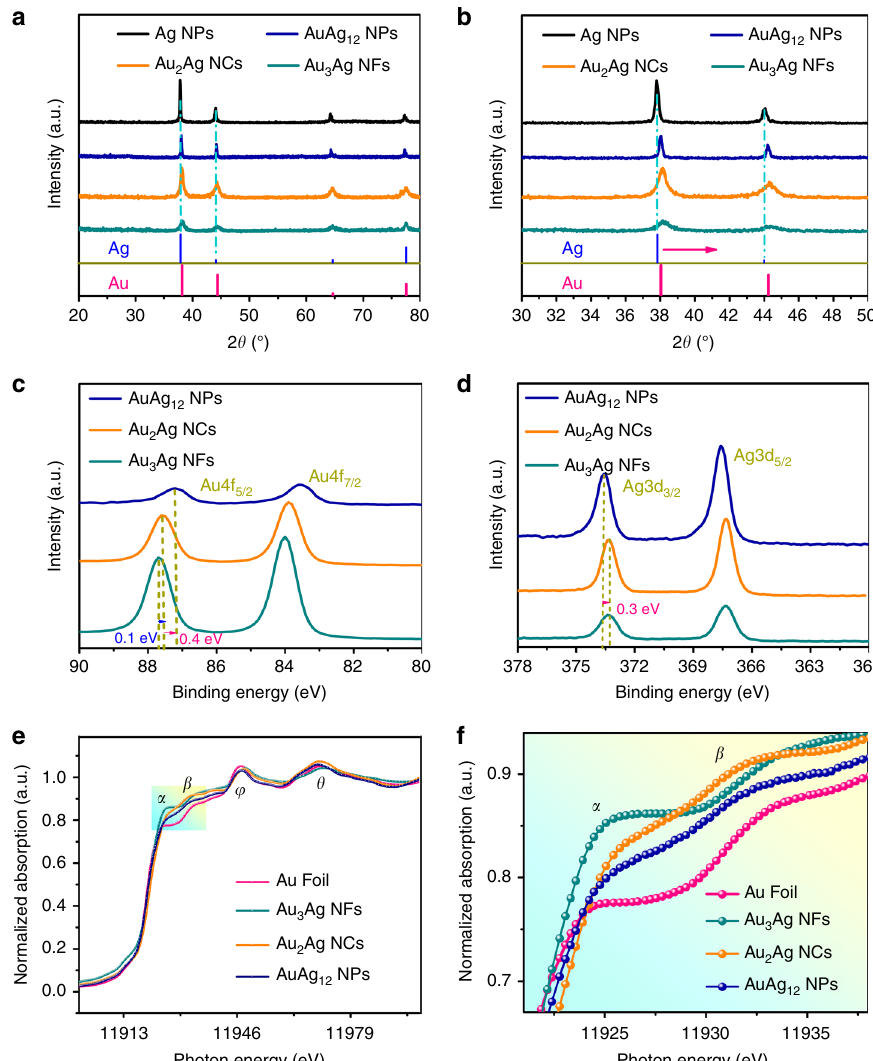
Fig. 3 Spectroscopy analysis on the structural evolution for all AuAg nanostructures. a X-ray diffraction (XRD) and b zoom-in spectra of Ag NPs, AuAg 12 NPs, Au 2 Ag NCs, and Au 3 Ag NFs. c X-ray photoelectron spectroscopy (XPS) Au 4f and d Ag 3d spectra of AuAg 12 NPs, Au 2 Ag NCs, and Au 3 Ag NFs. e X-ray absorption near-edge structure (XANES), and f zoom-in spectra obtained from the Au L 3 -edge absorption of AuAg 12 NPs, Au 2 Ag NCs, and Au 3 Ag NFs in comparison to the gold